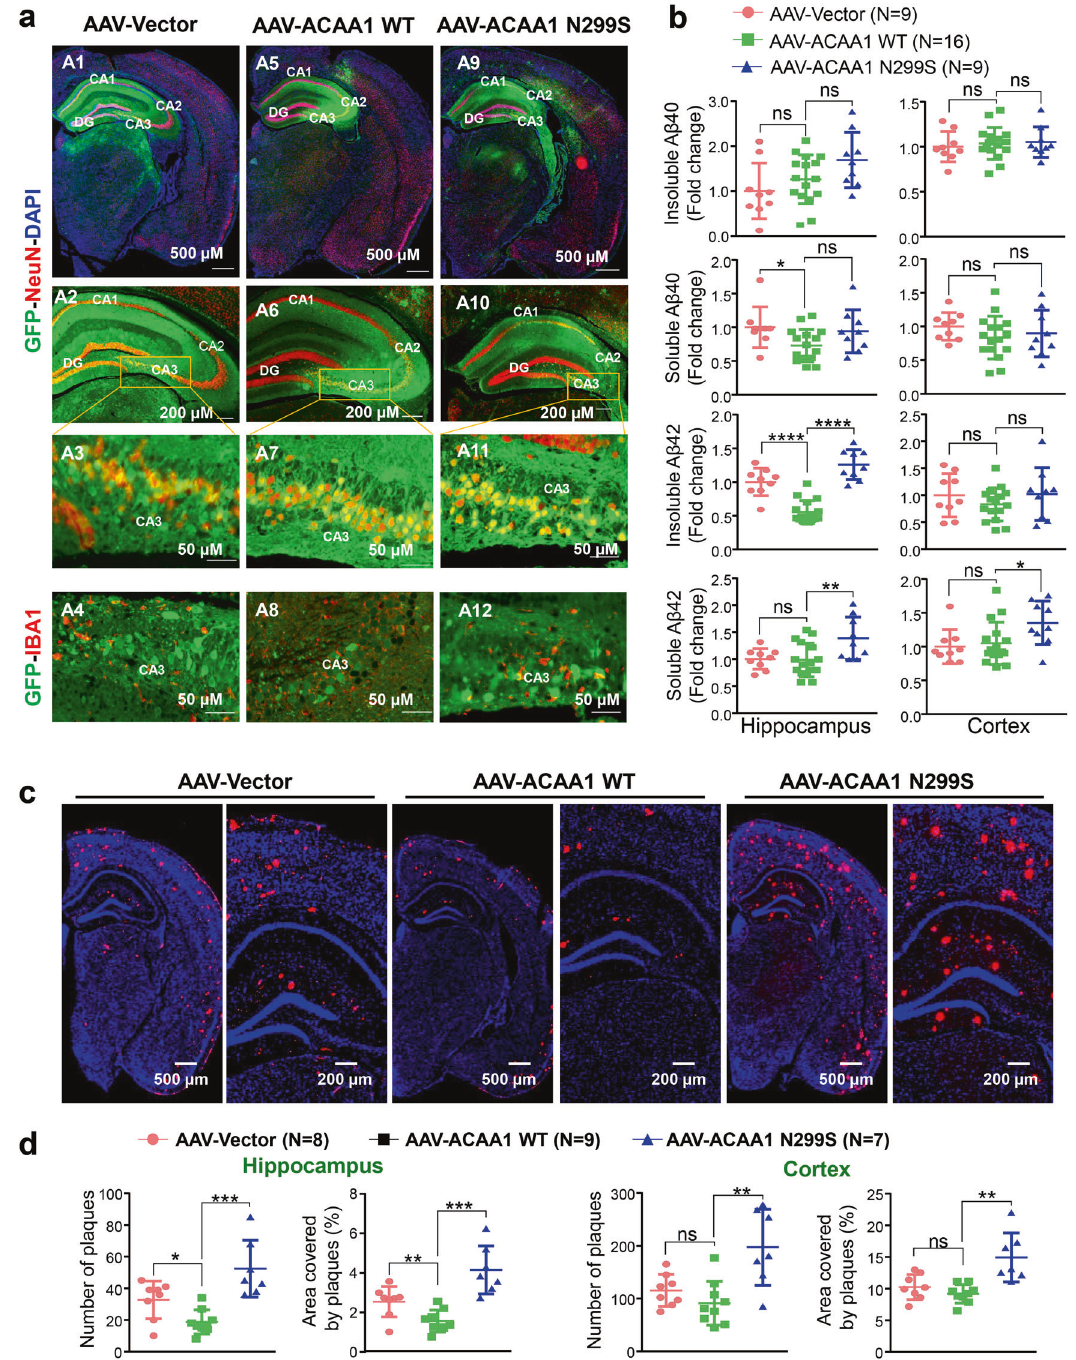
Fig. 4 Overexpression of ACAA1 p.N299S via adeno-associated virus delivery exacerbated amyloid- β (A β ) pathology. APP/PS1 Δ E9 mice and WT littermates were injected with AAV-Vector, AAV-ACAA1 WT, or AAV-ACAA1 N299S at 3 months of age and sacri fi ced at 9 months of age. a Fluorescent signals in the brain section of a 9-month-old mouse receiving AAV-Vector, AAV-ACAA1 WT, or AAV-ACAA1 N299S. b Quanti fi cation of soluble and insoluble A β 40 and A β 42 in the hippocampus and cortex tissues of mice in a by ELISA. c , d Representative microphotographs of hippocampal sections stained with an 4G8-speci fi c A β antibody ( c ), and quantitative analysis of the number of A β plaques shown by 4G8 immunoreactivity in hippocampal and cortex tissues in APP/PS1 Δ E9 mice ( d ). Bars represent mean ± SD. ns, not signi fi cant; * P < 0.05; ** P < 0.01; *** P < 0.001; **** P < 0.0001; Student ’ s t test